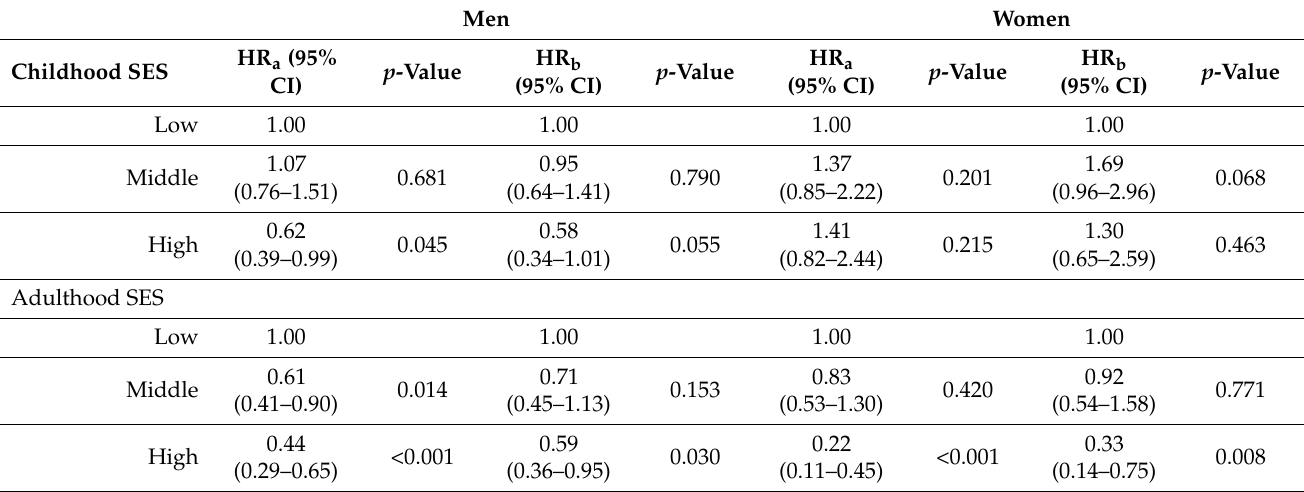
Table 3. Associations between the socioeconomic status index and cardiovascular disease death. Men